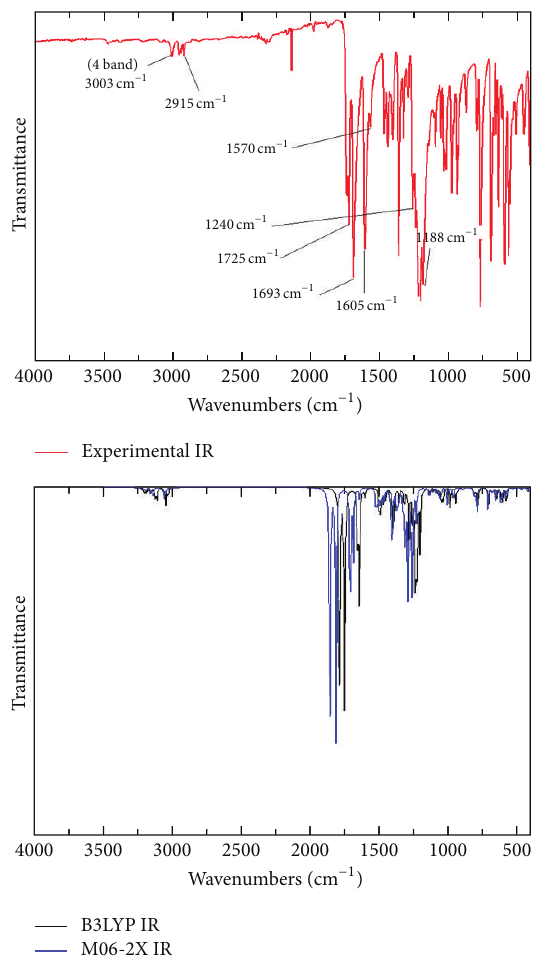
Figure 3: Comparison of observed and calculated Raman spectra of compound 2